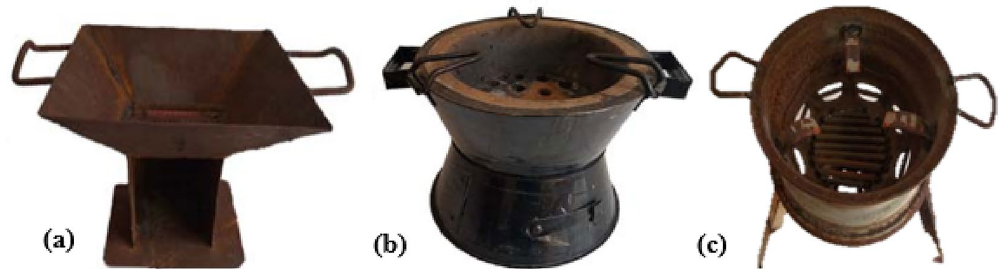
Figure 1. ( a ) Open air inlet. ( b ) Closed air inlet. ( c ) Open